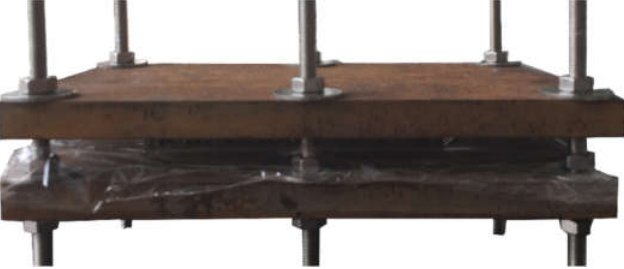
Figure 3. The fixture utilized for the fabrication of SLJs and AFSs.